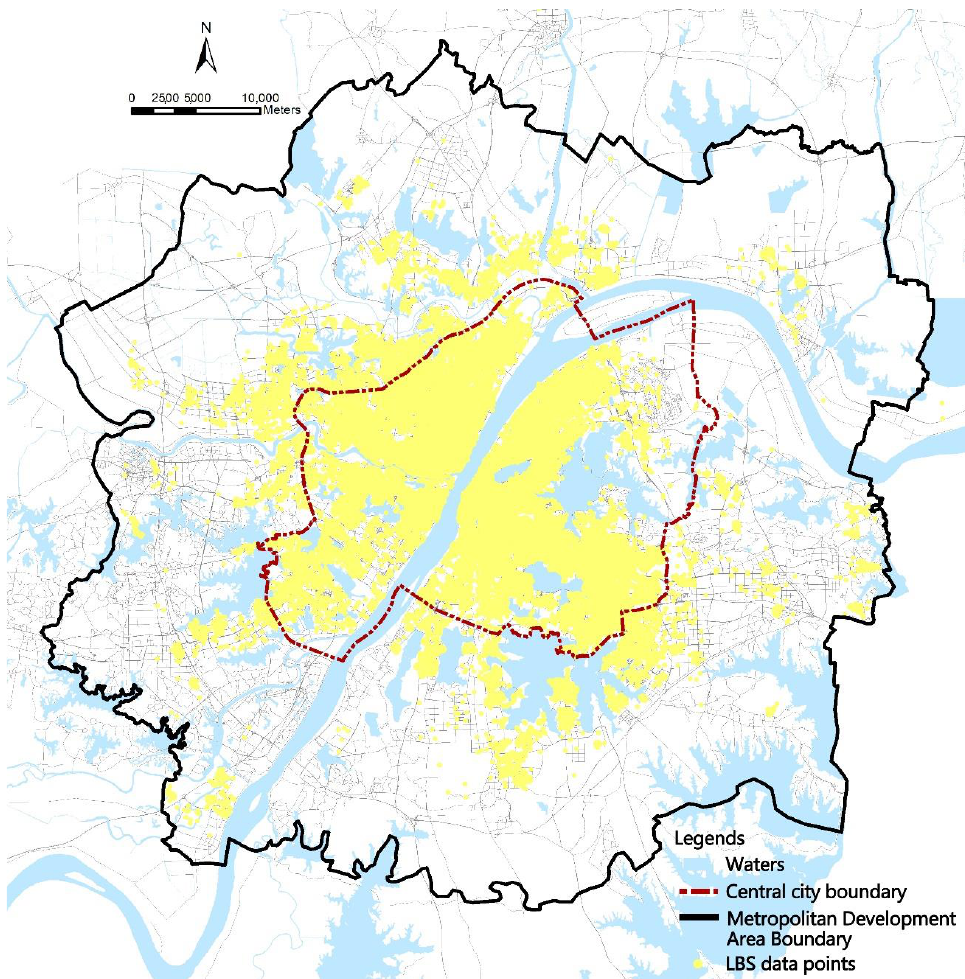
Figure 1. Wuhan city district map.